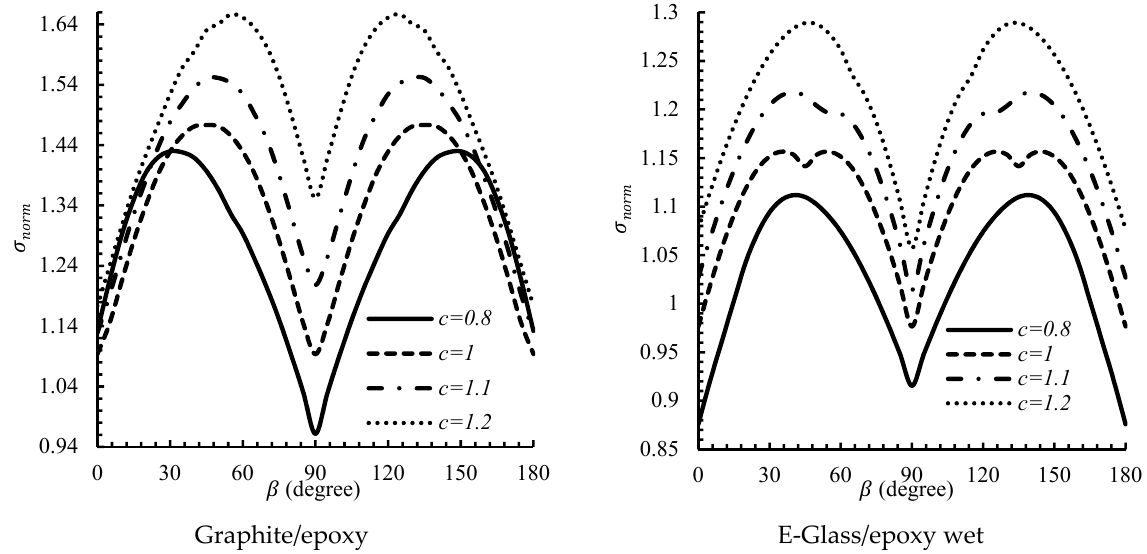
Figure 7. Effect of hole rotation angle on the maximum normalized stress in different values of c.